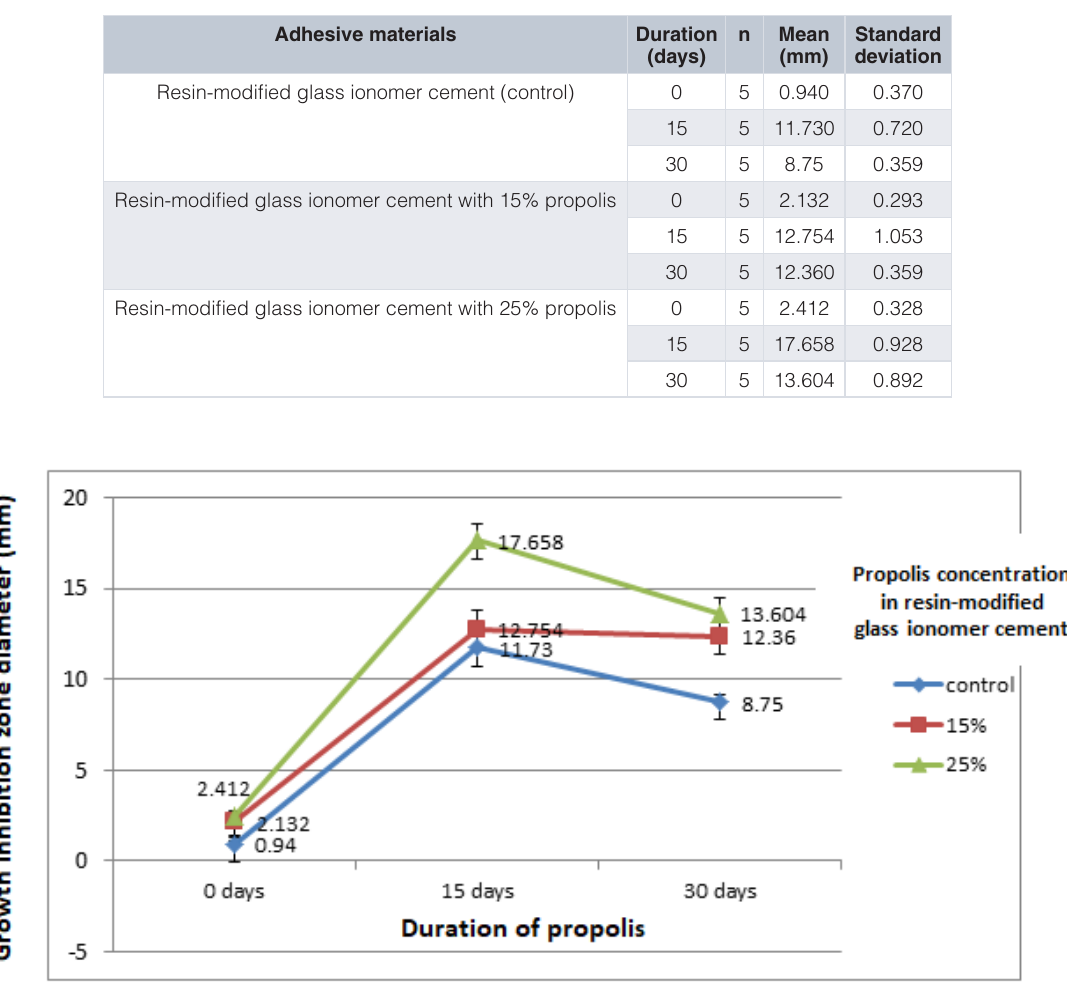
Figure 4. Means and standard deviation of growth inhibition zone of Streptococcus mutans among